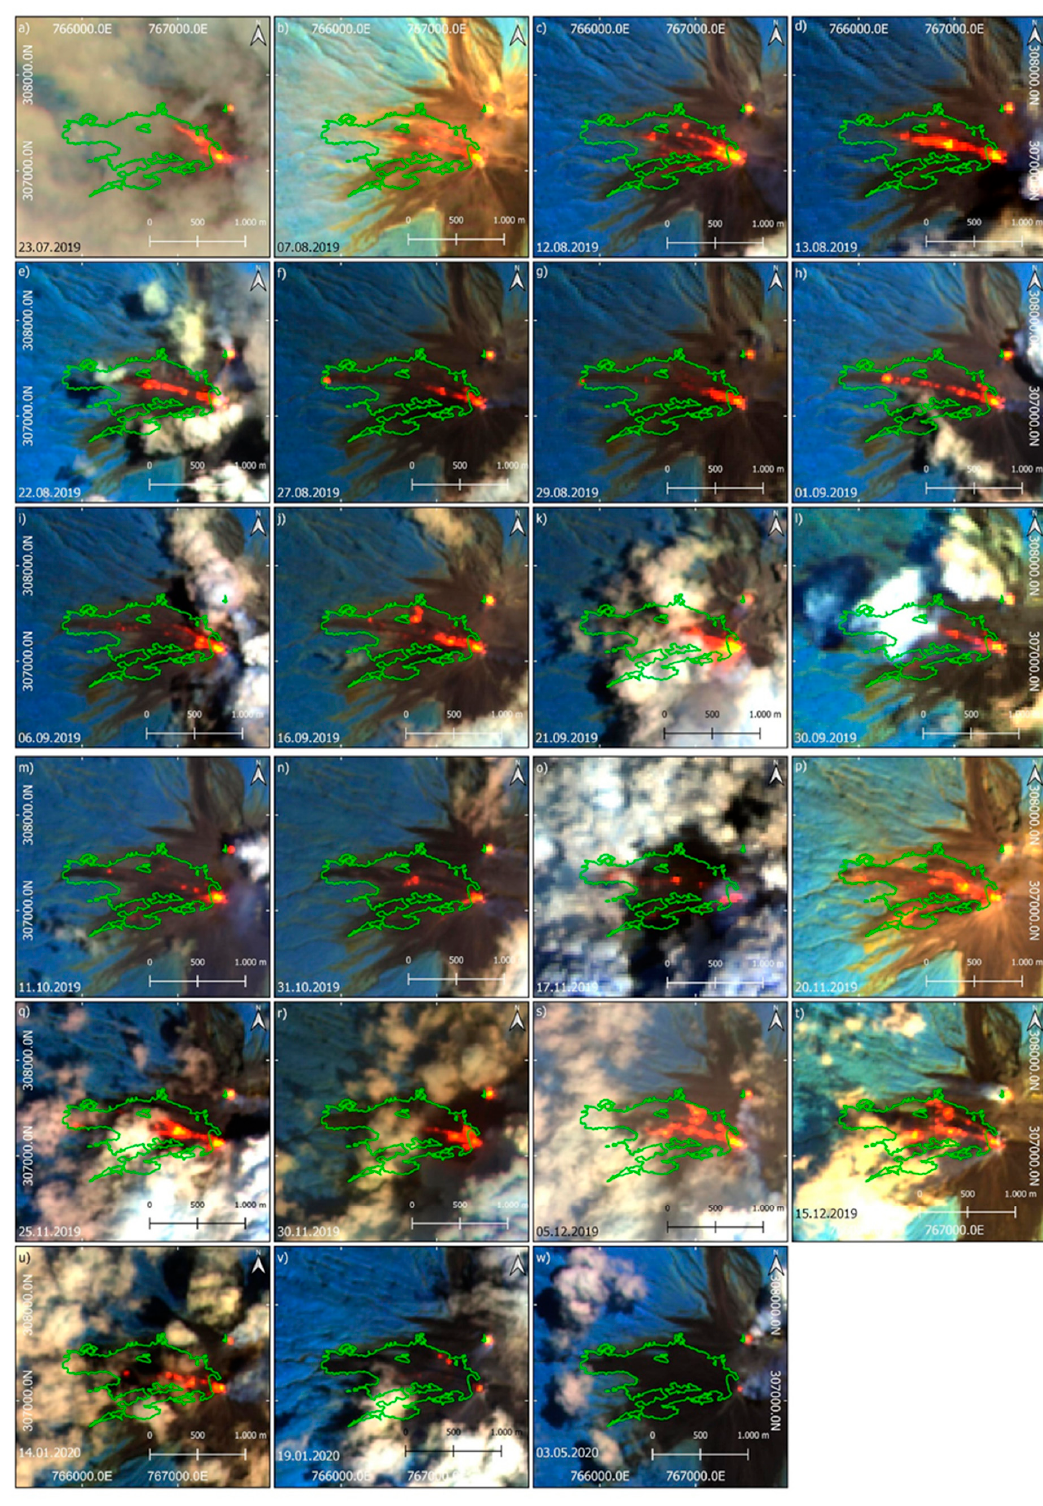
Figure A3. Multispectral false-color time series (Sentinel-2 and Landsat-8) in the SWIR2/SWIR1/NIR band combination during the Karangetang II eruption period. The classified lava area (in green) outlines the thermal anomalies that occurred. ( a – w ) Volcanic activity and evolution of lava flow towards the W flank. Thermal anomalies of the lava flow are displayed in red to yellow, with yellower pixel indicating higher